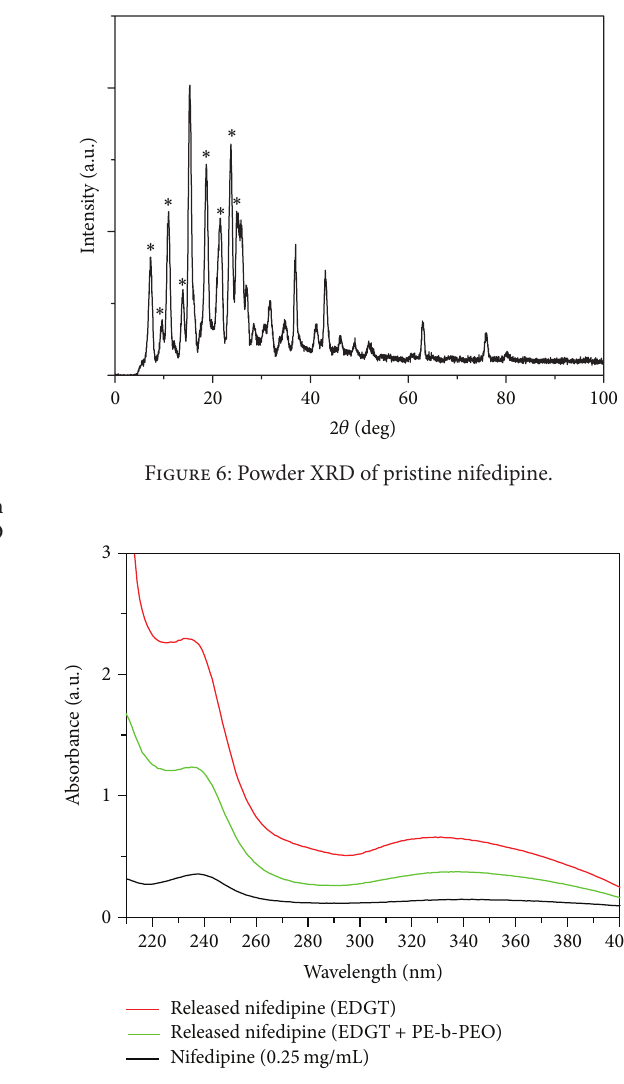
Figure 7: UV-vis spectrum of pristine nifedipine and released drug from electrospun fibers of Eudragit L-100 and Eudragit L-100 + PE-